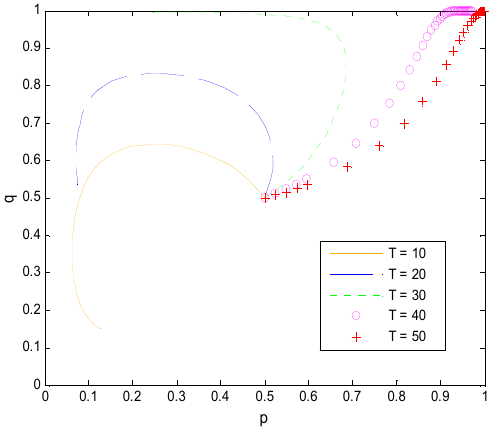
Figure 11. The evolution process of the change of T .